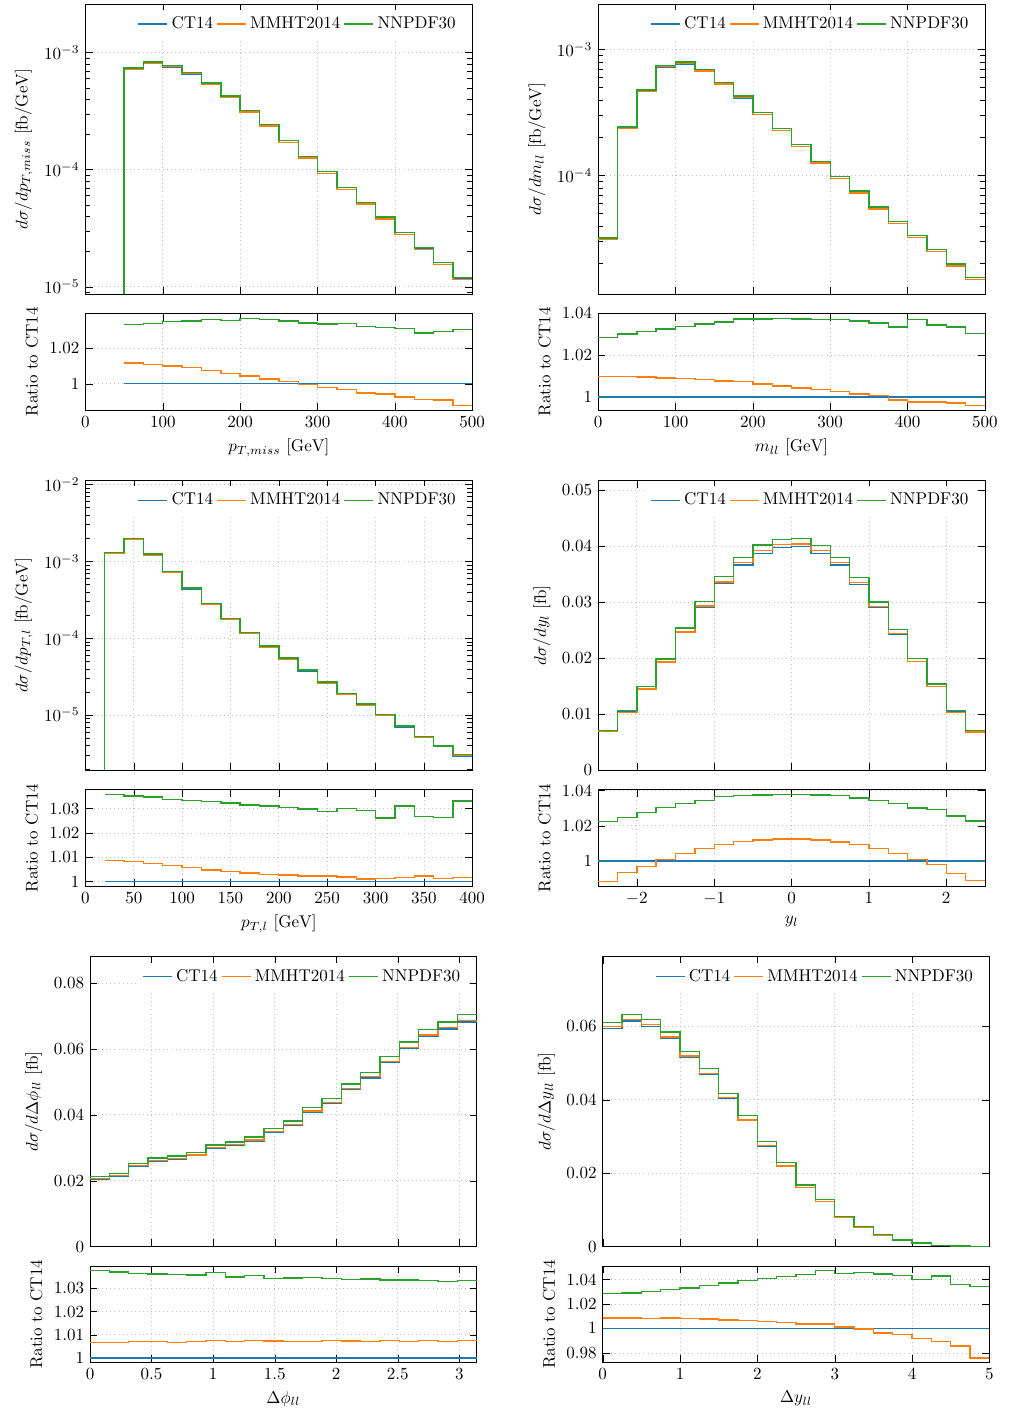
Figure 13 . Di(cid:11)erential cross section distributions for pp e + (cid:23) e (cid:22) (cid:0) (cid:22) (cid:23) (cid:22) b (cid:22) b (cid:23) (cid:28) (cid:22) (cid:23) (cid:28) + X at the LHC run ! II with p s = 13 TeV. The upper plots show absolute NLO QCD predictions for three di(cid:11)erent PDF sets and for (cid:22) 0 = H T = 3. Lower panels display the ratio to the default CT14 set. The following observables are presented: p miss , m ‘‘ , (averaged) p T;‘ , (averaged) y ‘ as well as (cid:1) (cid:30) ‘‘ and (cid:1) y ‘‘ . T